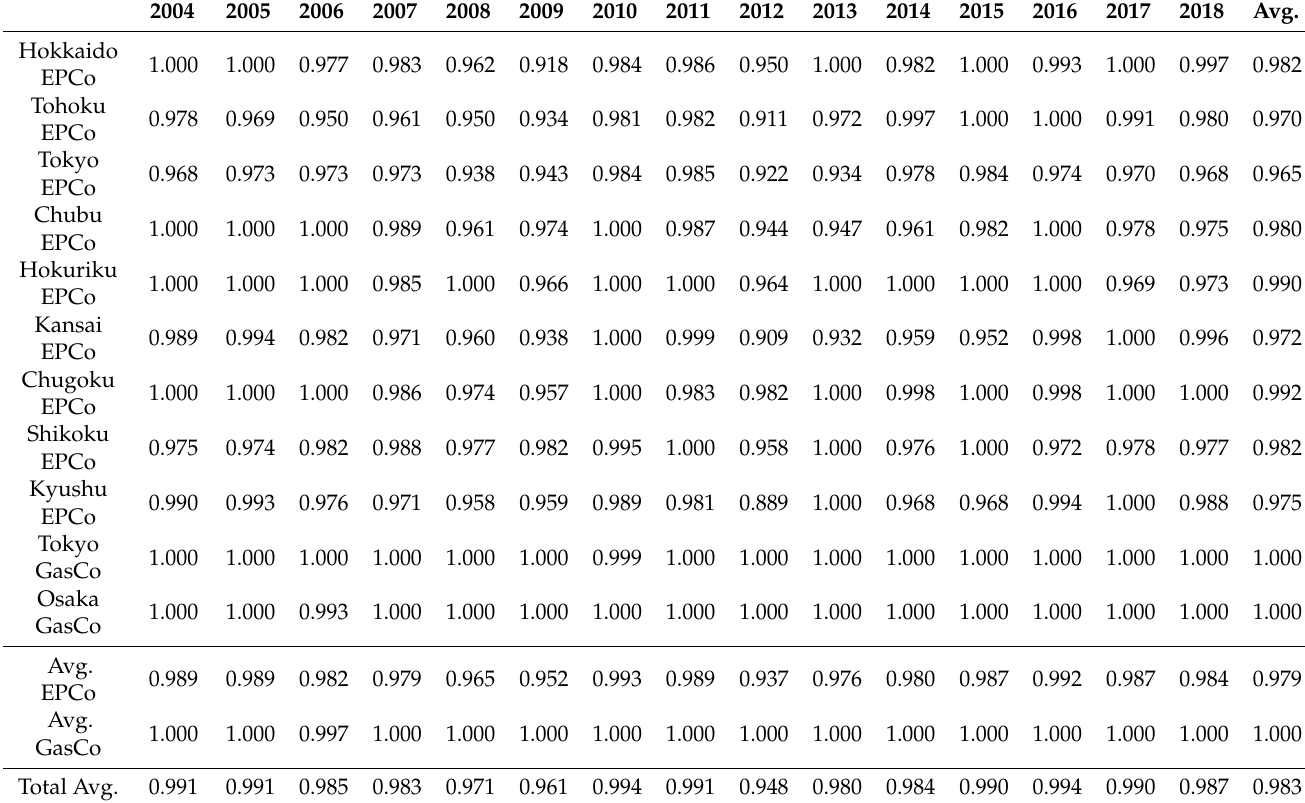
Table 3. Operational Efficiencies (WOE) of Utility Firms: Window